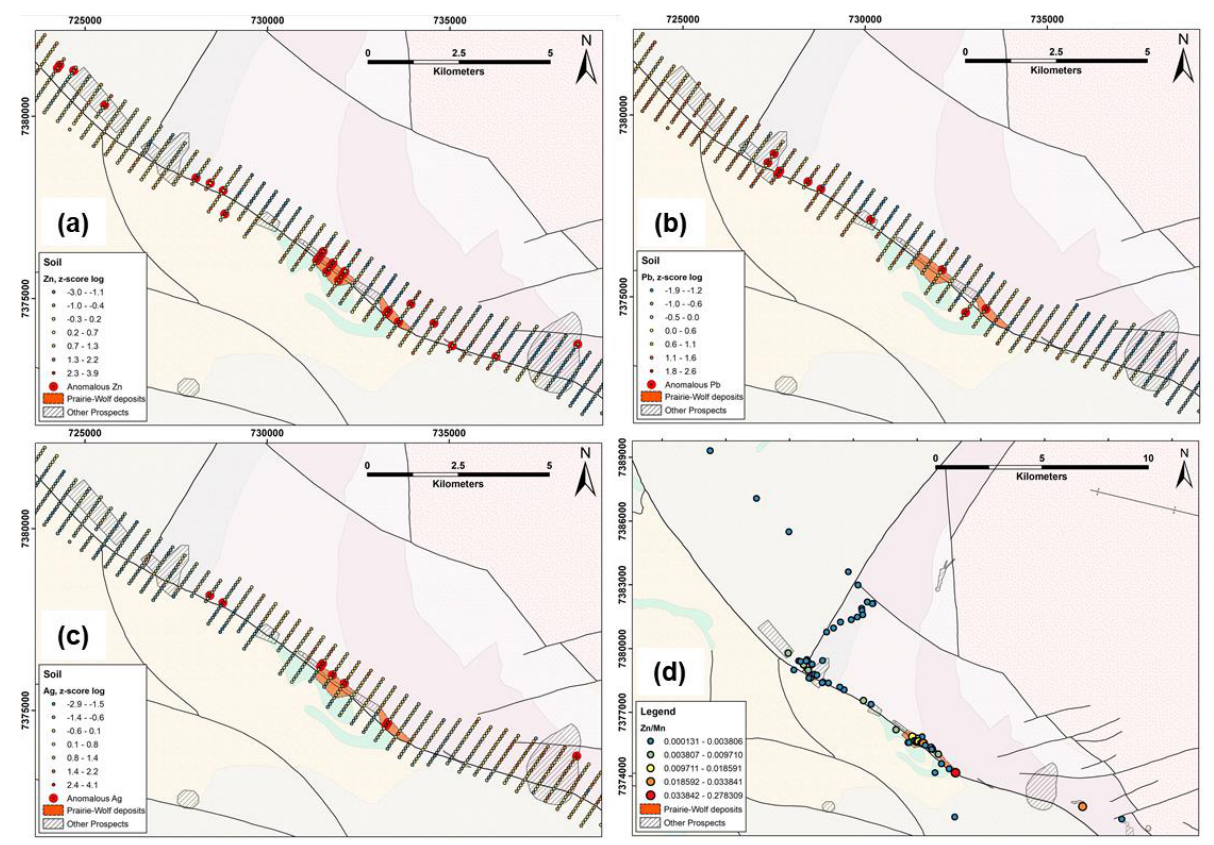
Figure 6. Relative spatial metal distribution and anomalous values in soil and ferro-manganese crust samples afterSpinks et al. (2017) [23]. Soil data displayed in these maps are log-transformed and z-score normalized. Anomalous values have been determined via probability plots. Data below detection limit have been replaced with half detection limit values. ( a ) Zn concentration in soil samples. ( b ) Lead concentrations in soil samples. ( c ) Silver concentrations in soil samples. ( d ) Zinc concentrations (normalized to Mn) in ferro-manganese crust samples reproduced from Spinks et al. (2017) [23] with permission. Please refer to the Supplementary Data for a lithological legend.